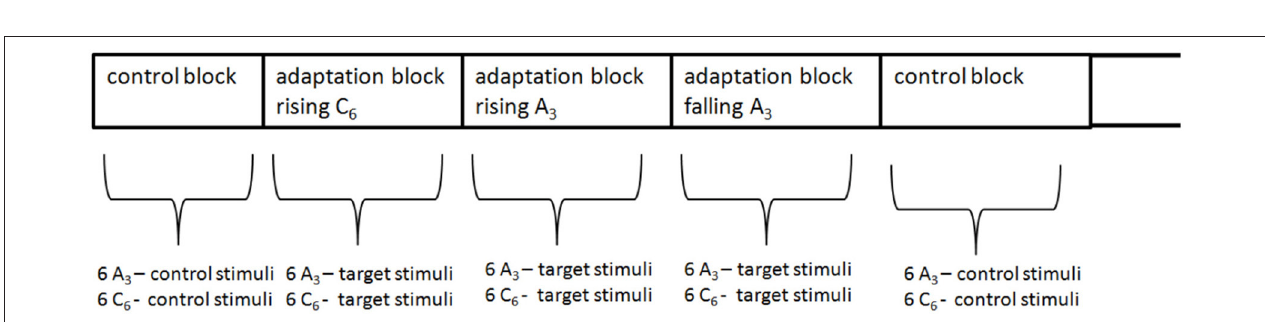
FIGURE 4 | Procedure of an adaptation block: an adaptation block started with a 43 s adaptor sequence (rising/falling × A 3 / C 6 -envelope). Each trial consisted of the first 7 tones of the adaptor sequence and the target stimuli. Each block contained A 3 and C 6 target stimuli.